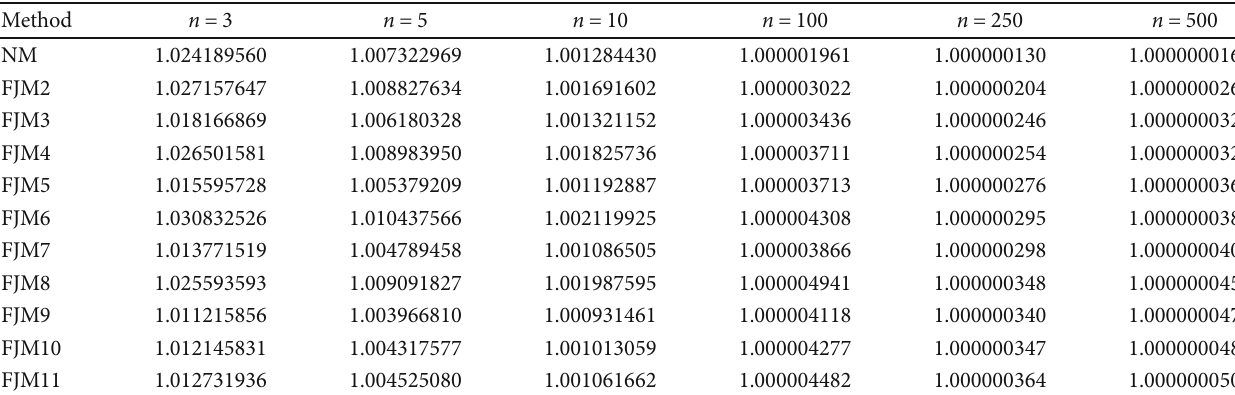
Table 35: Values of CI for the methods in the third category to solve Test Problem 1, and n = 3, 5, 10,100,250,500 . Method